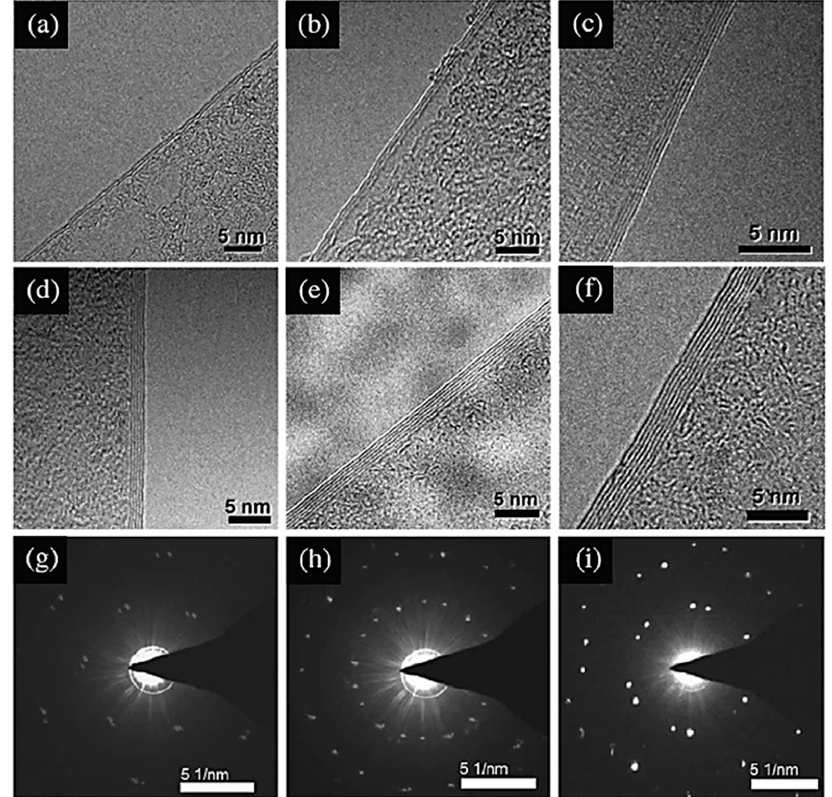
Figure 4. TEM micrographs of Gp edges with di ff erent layer numbers: ( a ) two layers, ( b ) three layers, ( c ) four layers, ( d ) five layers, ( e ) six layers, and ( f ) seven layers. The SAED patterns of two, three, and five layers of Gp taken from the center of the domain are presented from ( g – i ). Reprinted with permission from [60]. Copyright RSC Publishers,